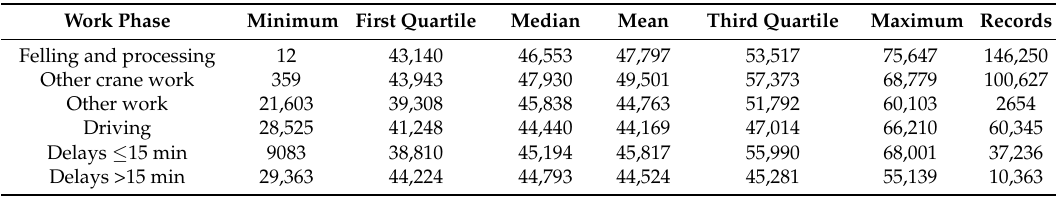
Table 1. Descriptive statistics for the recorded tensile forces in Newton (N) at the harvester divided into defined work phases.